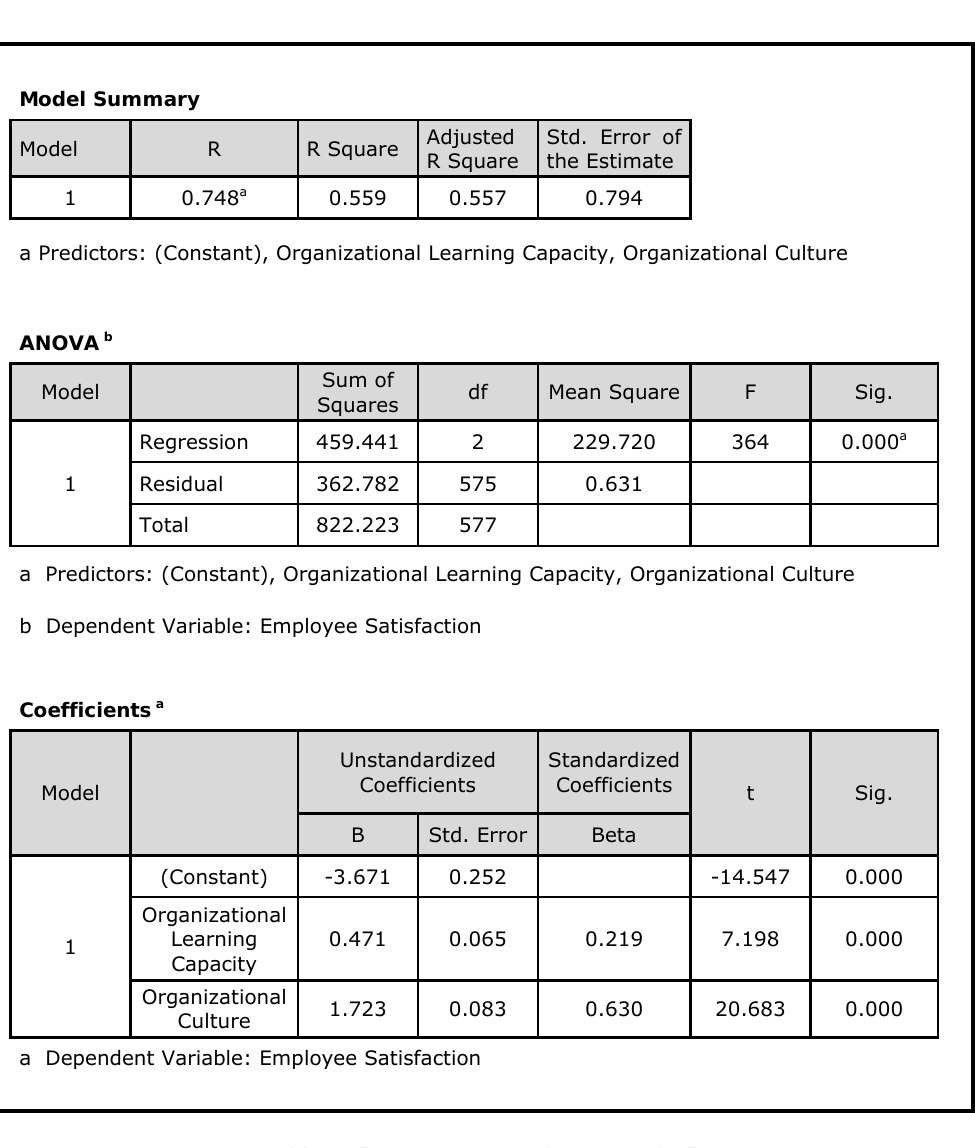
Table 5. “Regression Analysis